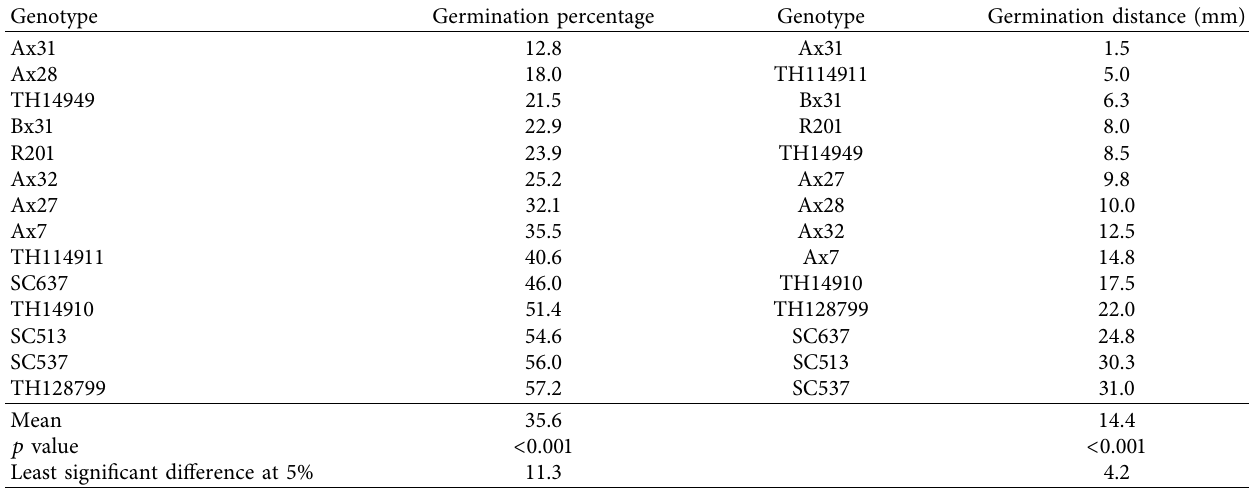
Table 8: Germination percentages and furthest germination distance means of IITA and local checks recorded under laboratory conditions.